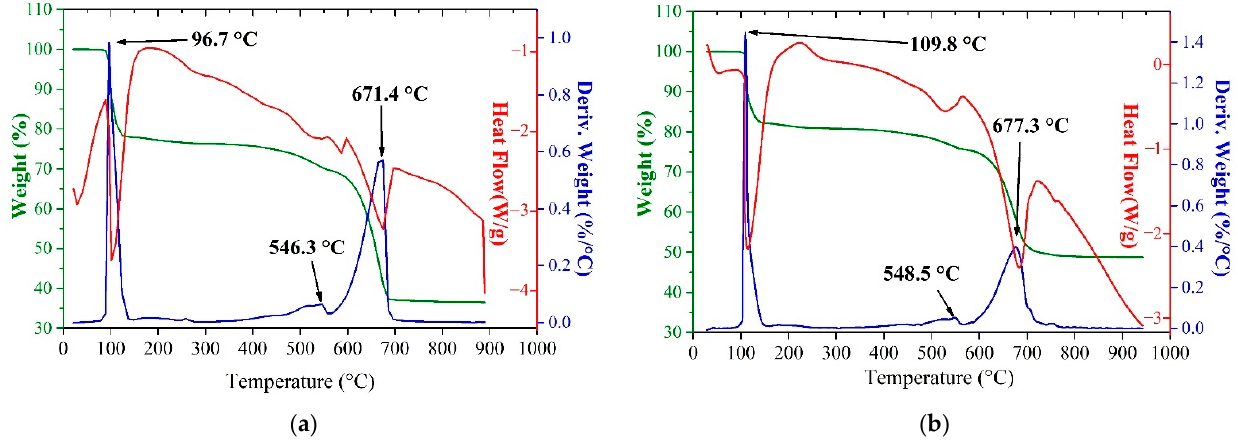
Figure 3. TG-DSC thermogram of pure FeSO 4 ∙ 7H 2 O ( a ) and ZnFe 2 O 4 + FeSO 4 ∙ 7H 2 O mixture in 1:4 molar ratio excluding hydrated moisture ( b ).